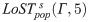
5-minute population coverage by district.(a) Population coverage. (b) Population LoST, LoSTpop s(Γ,5).